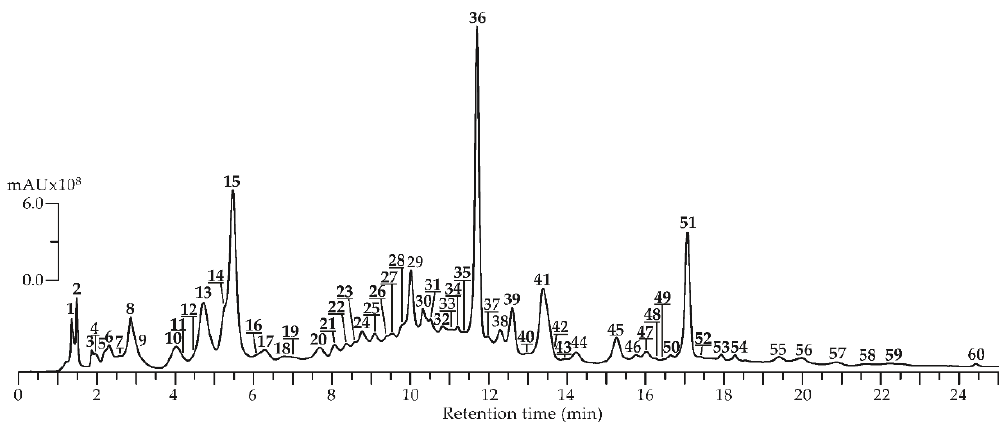
Figure 2. High-Performance Liquid Chromatography with Photodiode Array Detection and Electrospray Ionization Triple Quadrupole Mass Spectrometric Detection (HPLC-PDA-ESI-tQ-MS) chromatogram (Total Ion Chromatogram or TIC mode, negative ionization) of A. asiatica herbal extract. Compounds are numbered as listed in Table 3.